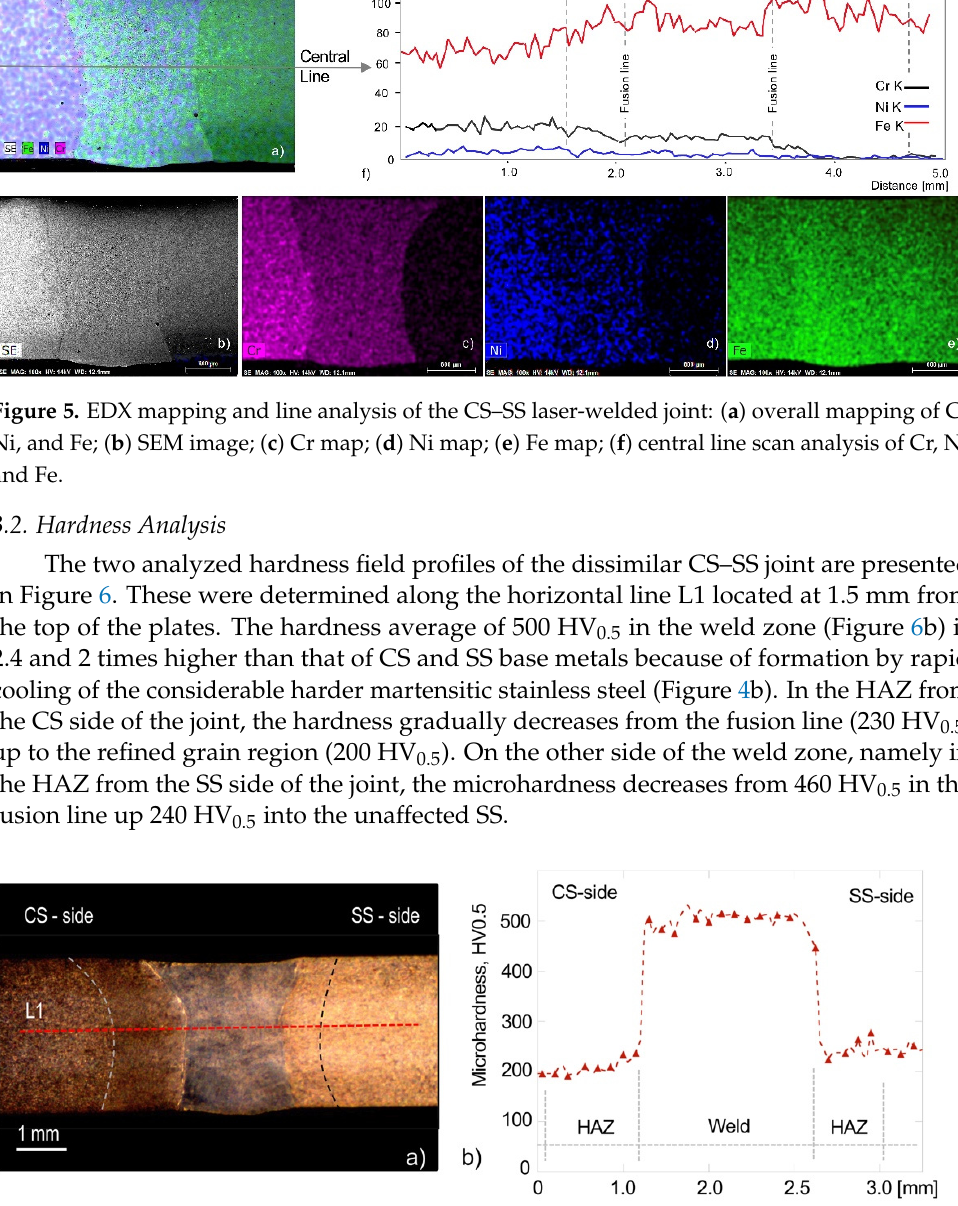
Figure 6. Hardness analysis. ( a ) Location of the microhardness imprint line L1 on the joint section; ( b ) microhardness profile along the analyzed line.